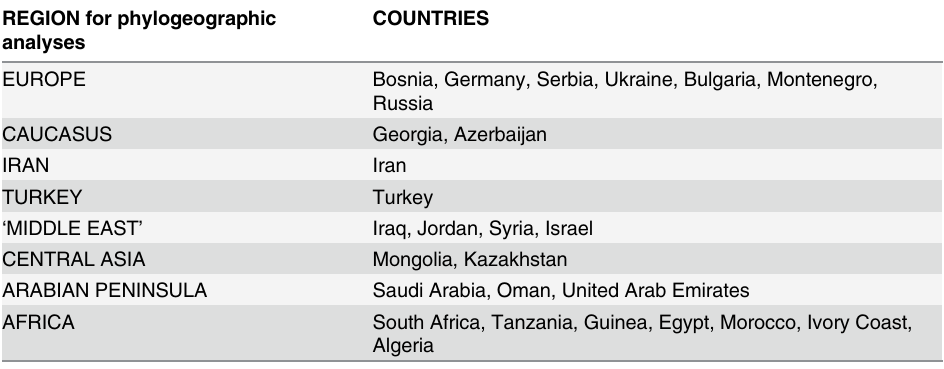
Table 2. Regional groupings for phylogeographic analyses. REGION for phylogeographic